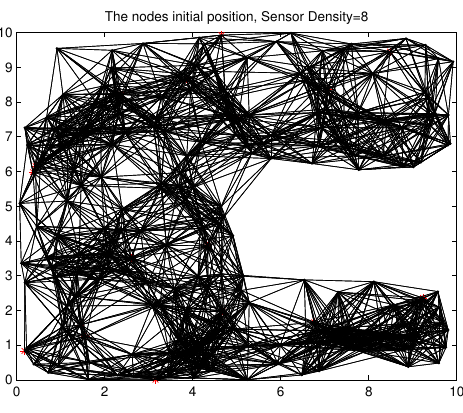
Figure 4. Irregular Topology: